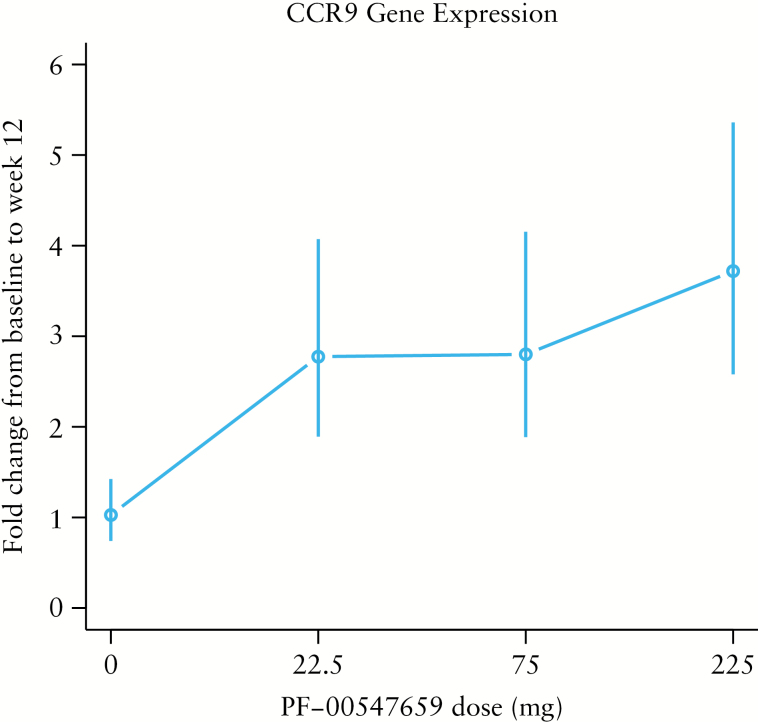
Fold changes in CCR9 gene expression [measured by counts per million] from baseline to Week 12 by treatment group. Each vertical line represents the 90% confidence interval for each fold change.